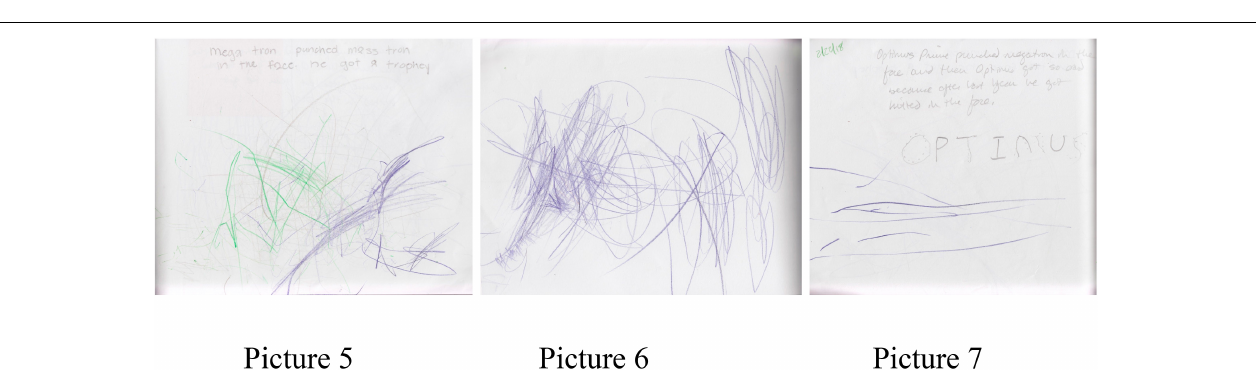
FIGURE 2 | Pictures 5–7 detailing a story from Norman, a 4-year-old